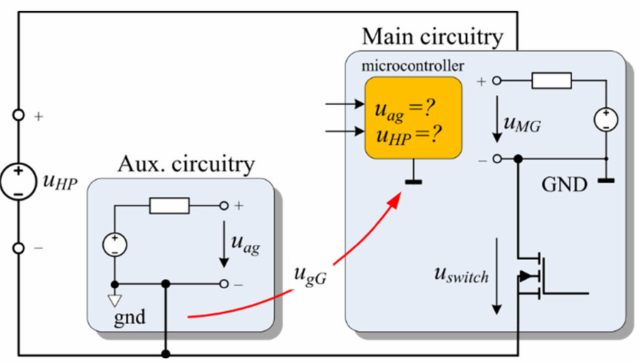
Figure 1. Simplified representation of an automotive device with a low-side safety